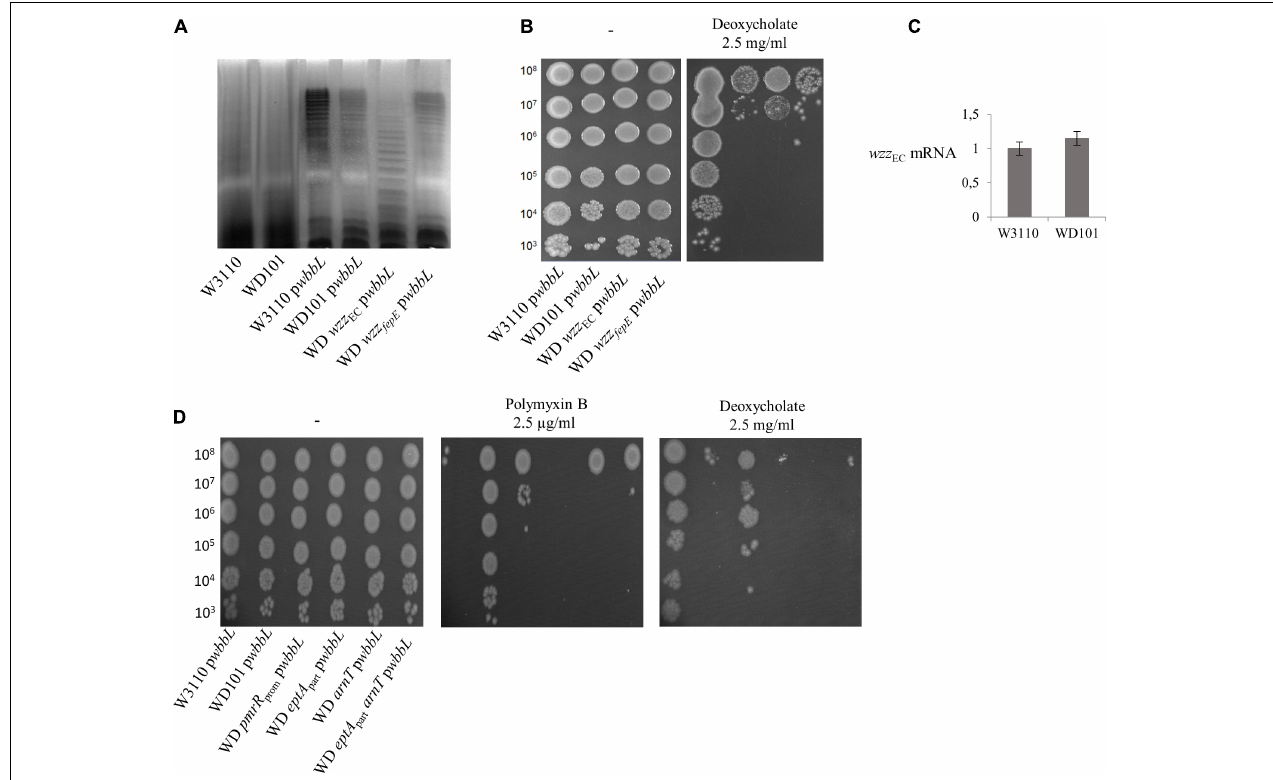
FIGURE 12 | Restoration of O-antigen biosynthesis does not affect deoxycholate and polymyxin B susceptibility. (A) O-antigen biosynthesis was restored in W3110, WD101 and its derivatives upon expression of wbbL gene (p wbbL plasmid). Bacteria were grown overnight in 2YT medium and their LPS was extracted according to Crawford et al. (2012), resolved by 15% SDS-polyacrylamide gel electrophoresis and visualized by silver-staining. (B,D) Bacteria expressing wbbL gene were grown overnight in 2YT medium and 5- µ l spots of serial dilutions were deposited onto 2YT plates containing or not polymyxin B (2.5 µ g/ml) and deoxycholate (2.5 mg/ml). (C) Q-PCR analysis of the transcriptional level of wzz EC and wzz fepE genes in W3110 and WD101 strains. Total RNAs were extracted from bacterial cells grown in 2YT medium up to OD 600 nm = 0.5 and they were used for cDNA synthesis. The level of mRNA was quantified by Q-PCR and normalized using housekeeping genes. The data are representative of at least three independent